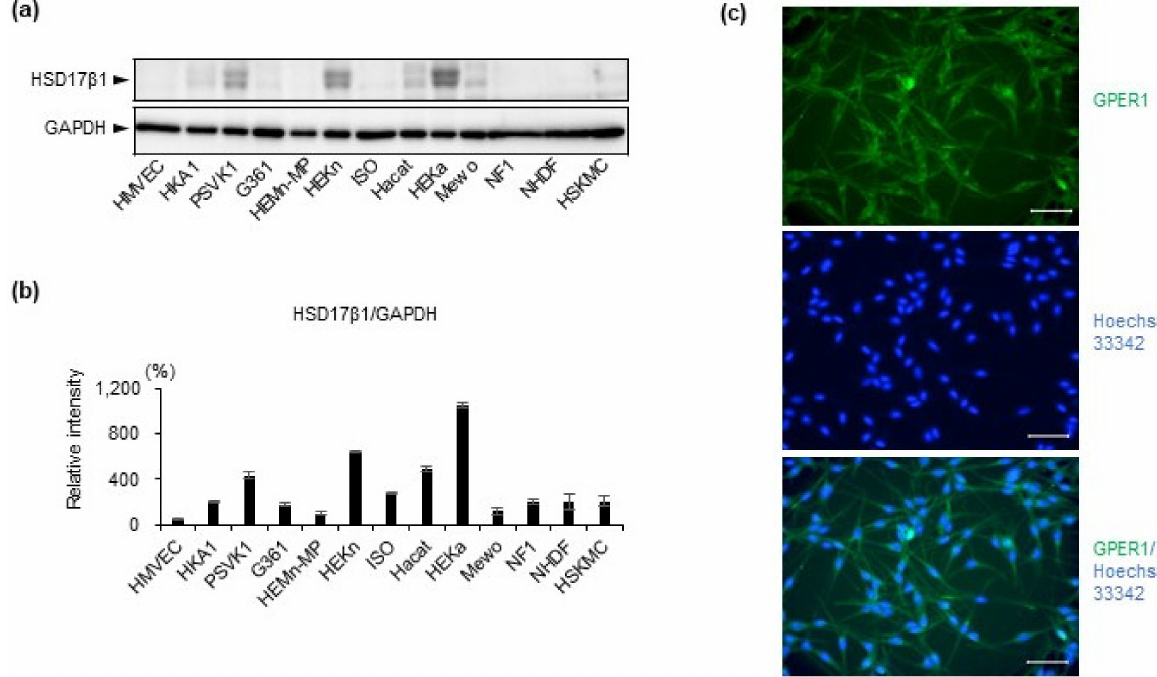
Figure 2. Protein expression levels of estrogen synthesis enzyme HSD17 β 1 and receptor GPER1 were analyzed by Western blot analyses and immunofluorescence staining. ( a ) Estrogen enzyme HSD17 β 1 protein expression level in lysates from indicated cultured cells was examined by Western blot analysis and the density of blot bands is quantified ( b ); ( c ) estrogen receptor GPER1 protein expression level in cultured melanocytes was examined by immunofluorescence staining with anti-GPER1 antibody (green) and Hoechst 33342 (blue). White bar, 50 µ m. Data in ( b ) represent the results of three independent experiments. Data are shown as means ±